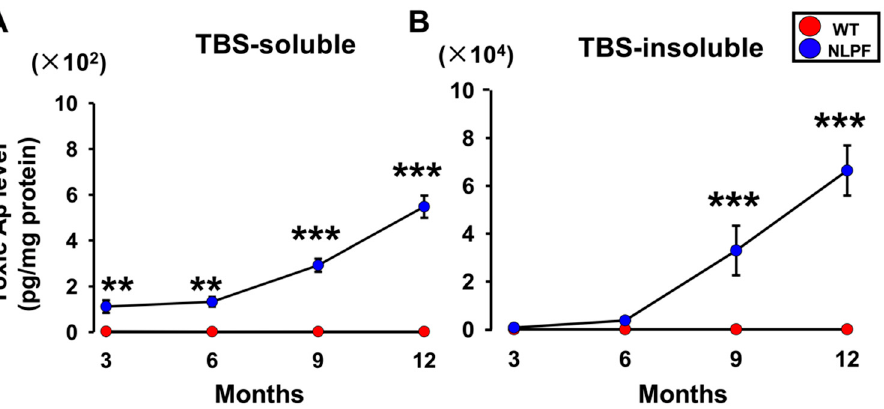
Figure 1. The toxic conformer accumulation in the brain of App NL-P-F/NL-P-F mice for three to twelve months. The levels of the toxic conformer of A β in ( A ) TBS-soluble and ( B ) TBS-insoluble fractions in the brains of App NL-P-F/NL-P-F mice from three to twelve months. ( A ) WT ( n = 4–5), NLPF ( n = 5). ( B ) WT ( n = 4–5), NLPF ( n = 4–5). The values indicate the mean ± SEM. ** p < 0.01, *** p < 0.001, compared with age-matched WT.